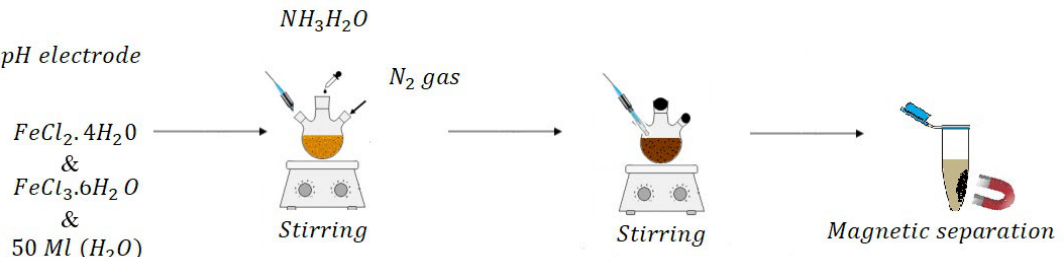
Fig. 3: Schematic of superparamagnetic nanoparticles